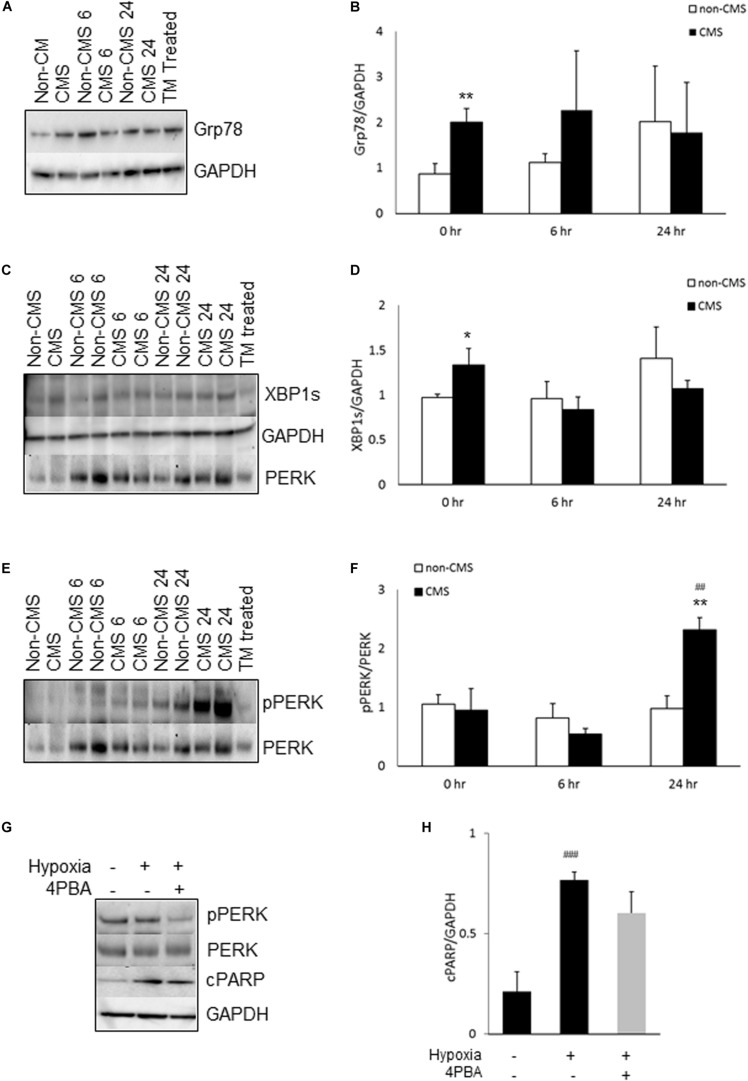
ER stress in CMS neurons. (A) A representative blot of Grp78 in iPSC-derived non-CMS neurons (n = 3) and CMS neurons (n = 3) following hypoxia (1% O2) treatment for 0, 6, and 24 h. Tunicamycin (TM)-treated CMS neurons as a positive control for ER stress. (B) Densitometry analysis of Grp78. (C) A representative blot of XBP1s in iPSC-derived non-CMS neurons (n = 3) and CMS neurons (n = 3) following hypoxia (1% O2) treatment for 0, 6, and 24 h. (D) Densitometry analysis of XBP1s. (E) A representative blot of PERK in iPSC-derived non-CMS neurons (n = 3) and CMS neurons (n = 3) following hypoxia (1% O2) treatment for 0, 6, and 24 h. (F) Densitometry analysis of PERK. (G). A representative blot of PERK and cPARP in iPSC-derived CMS neurons following hypoxia (1% O2) treatment for 0 and 48 h with or without 1 mM 4-PBA. (H) Densitometry analysis of cPARP. * indicates p < 0.05 and ** indicates p < 0.01 as compared to non-CMS neurons at a given time point. ## indicates p < 0.01 and ###p < 0.001 as compared to themselves under normoxia.